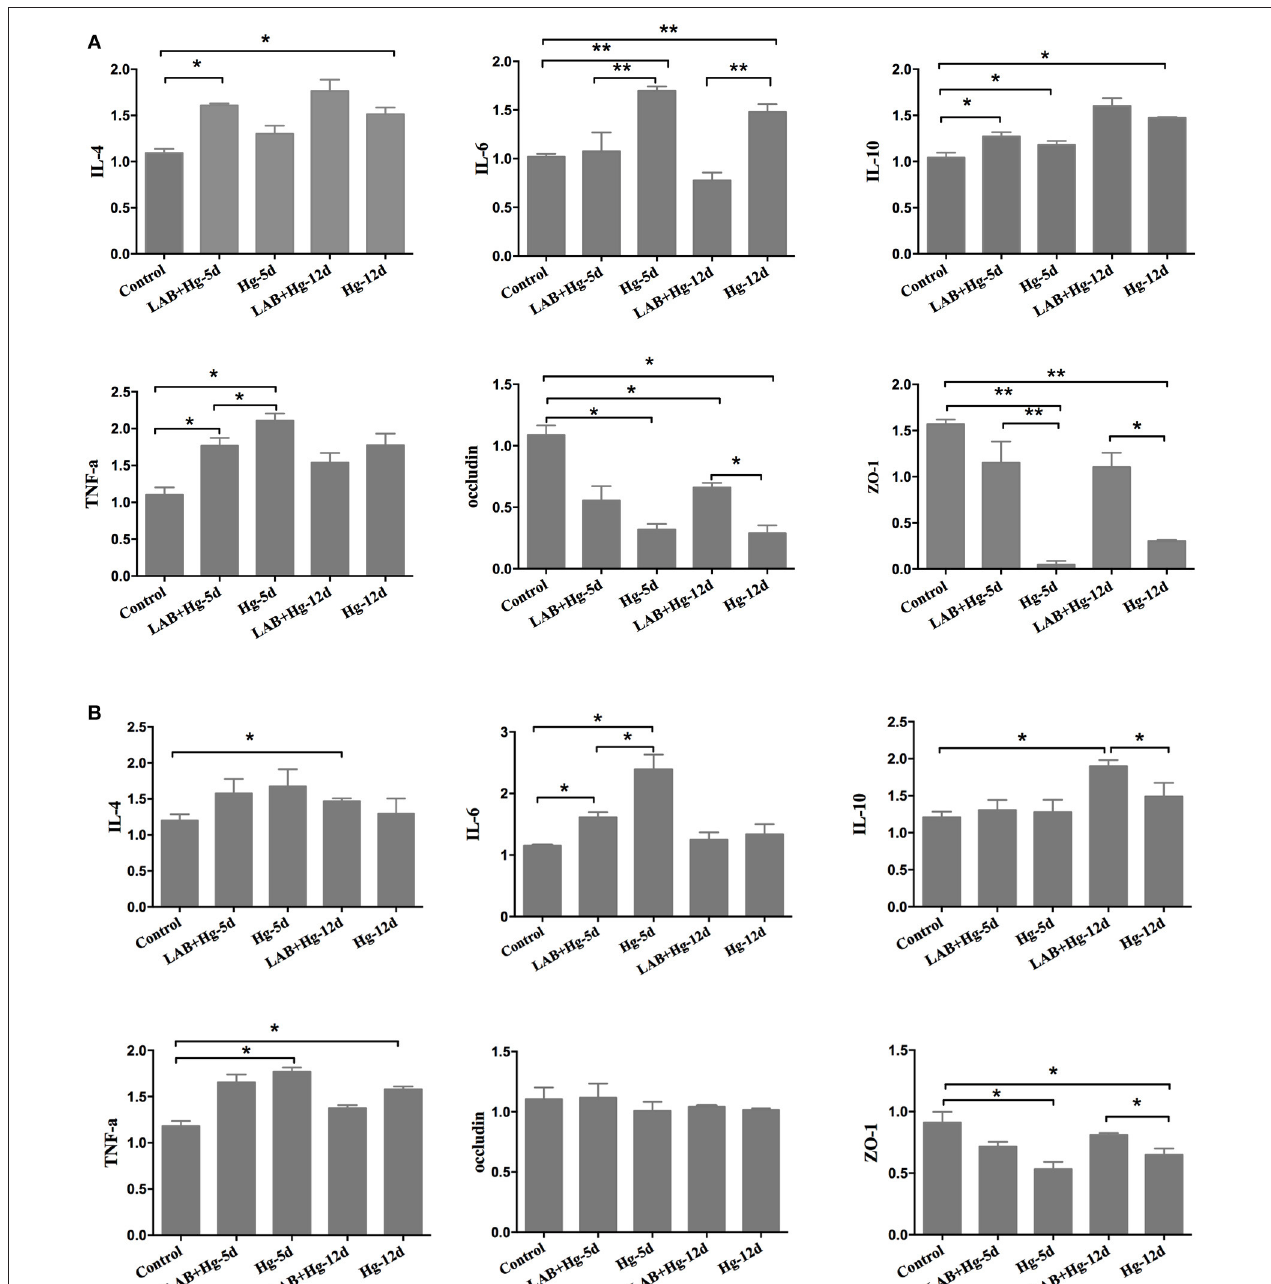
FIGURE 4 | Cytokines and intestinal integrity expression. RNA expression was analyzed in both the duodenum and jejunum,including for TNF- α , IL-4, IL-6, IL-10, occluding, and ZO-1. (A) Gene expression of cytokines and integrity in the duodenum. (B) Results in the colon. The differences between means were considered significant at * p < 0.05, very significant at ** p < 0.01. Results are represented as the mean ± SEM of three independent